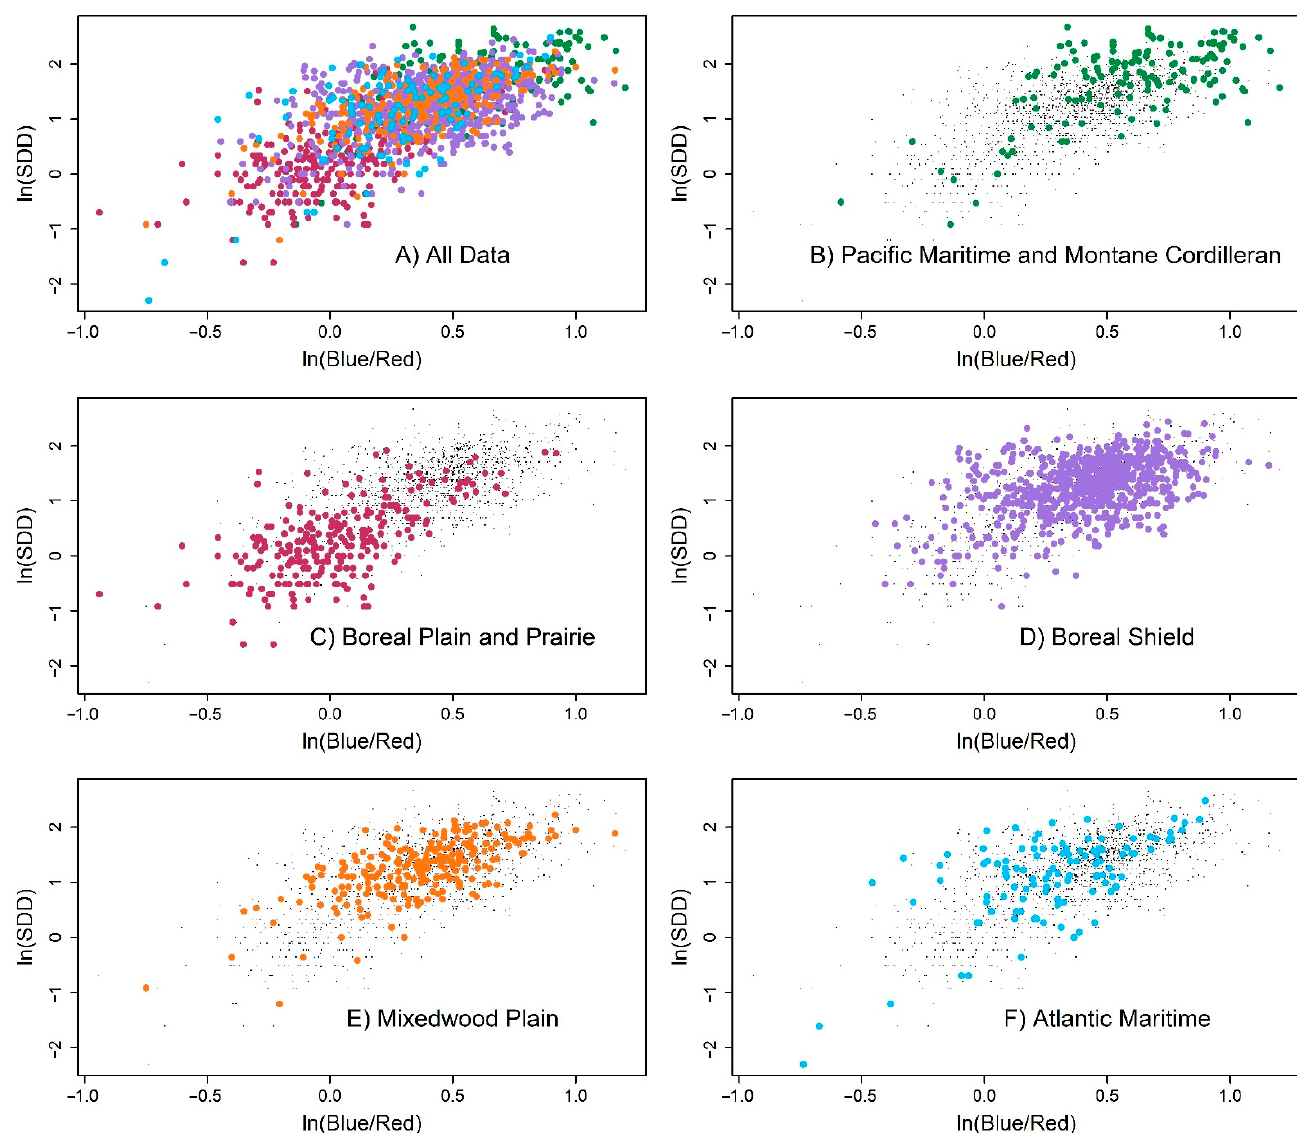
Figure 5. Using a 7-day day temporal window between the data of in situ sample and the date of satellite overpass: scat- terplots of ln(SDD) versus ln(Blue/Red) for ( A ) all ecozones together, and ( B – F ) individual ecozones or ecozone groupings plotted in color over a grey cloud representing the complete dataset. Points are color-coded by ecozone, consistent with previous plots. Green represents the Pacific Maritime and Montane Cordilleran, maroon represents the Boreal Plain and Prairies, purple represents the Boreal Shield, orange represents the Mixed Wood Plains, and blue represents the Atlantic Maritime.